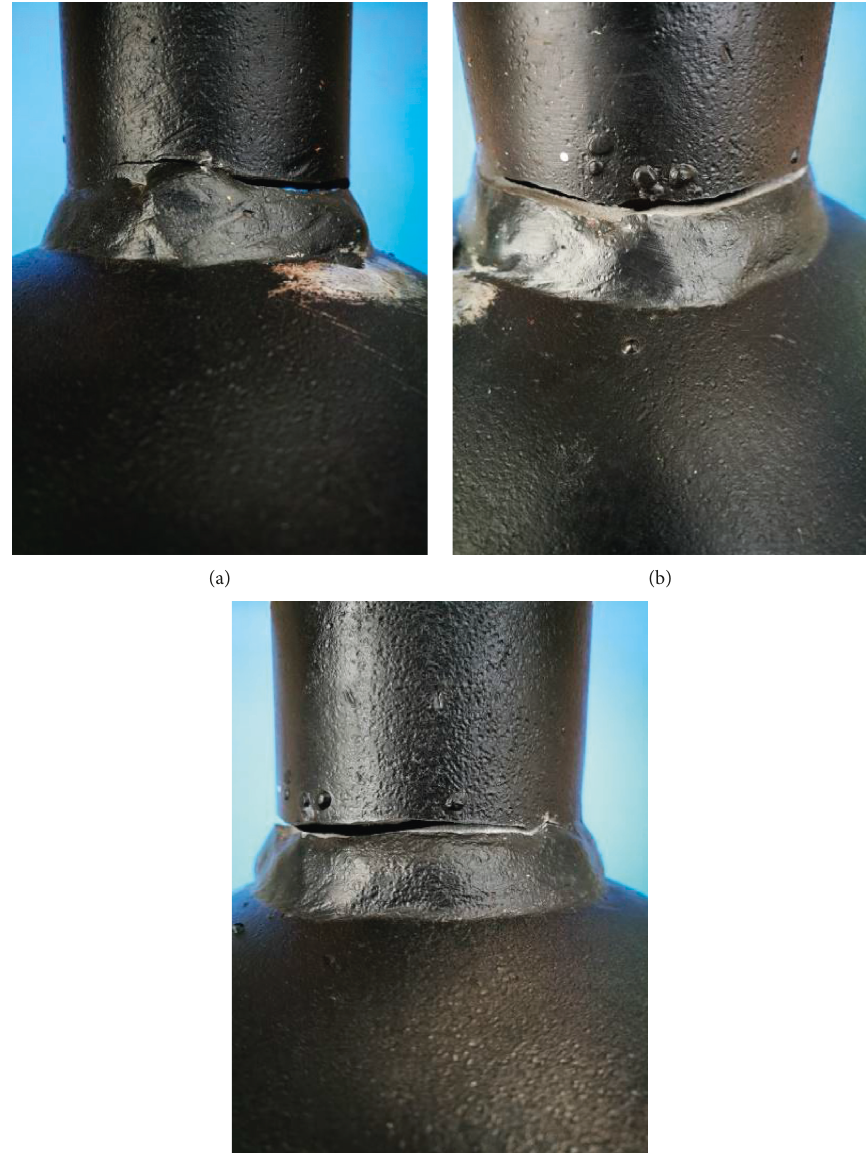
Figure 8: Typical fatigue failure mode (stress amplitude � 99MPa; stress ratio � 0.4). Left side (a), center (b), and right side (c) of the